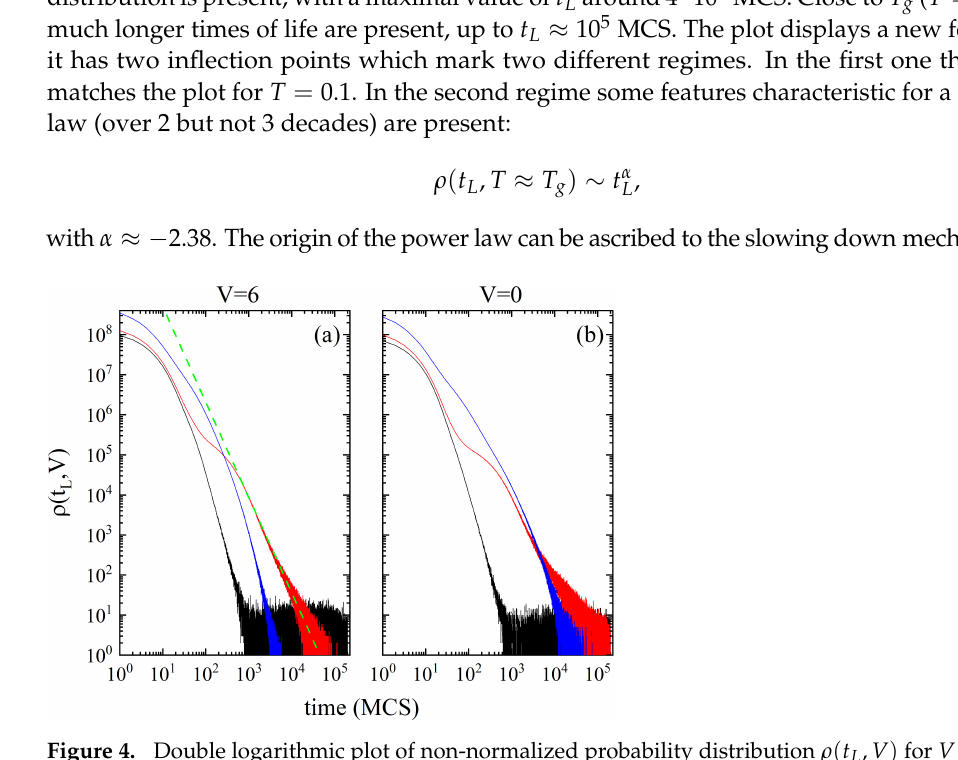
Figure 4. Double logarithmic plot of non-normalized probability distribution ρ ( t L , V ) for V = 6 ( a ) and V = 0 ( b ). T = 0.1 (black line), T = 0.25 (red line) and T = 0.5 (blue line). Green dashed line represents power